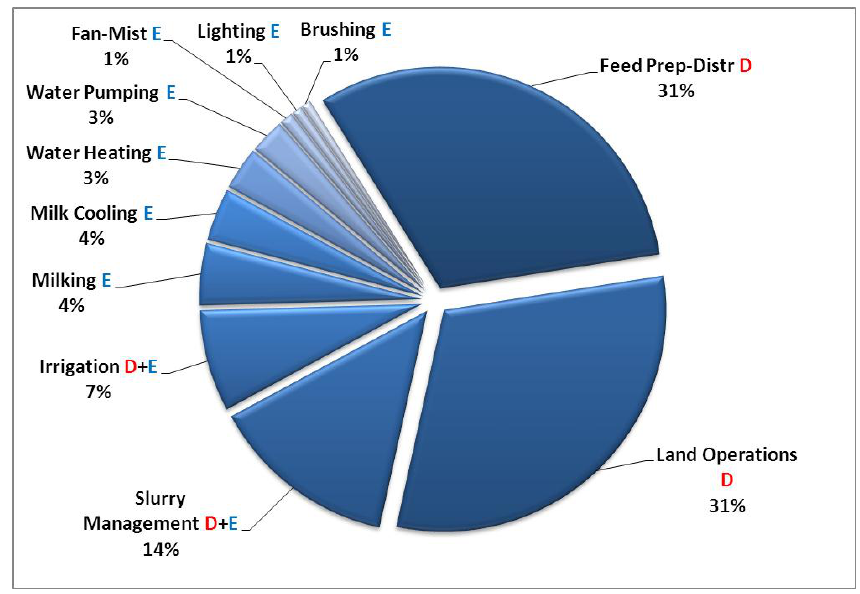
Figure 4. Distribution of GHG emissions from electricity ( E ) and diesel ( D ) to on-farm operations.